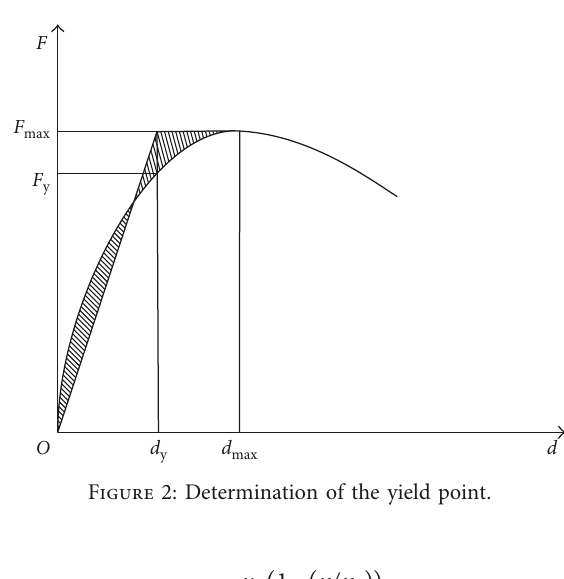
Figure 2: Determination of the yield